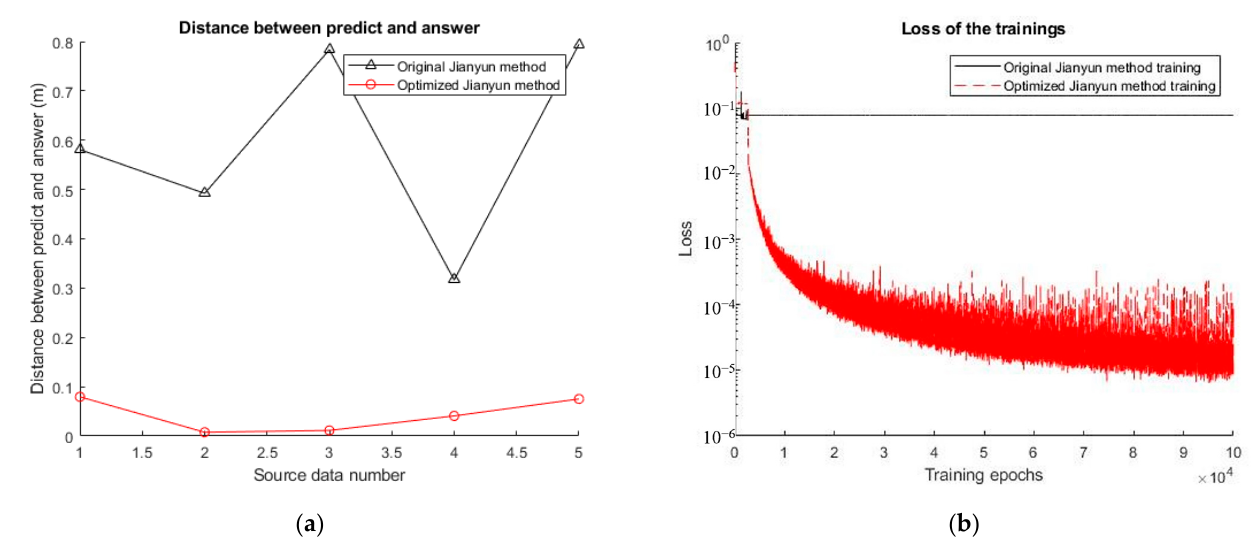
Figure 13. ( a ) Results obtained with Yangzhou’s method before and after optimization. ( b ) Training loss epochs obtained with Yangzhou’s method before and after optimization.